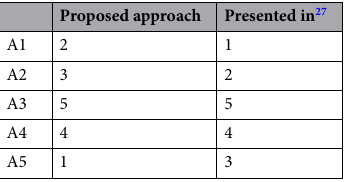
Table 12. Ranking of alternatives using two